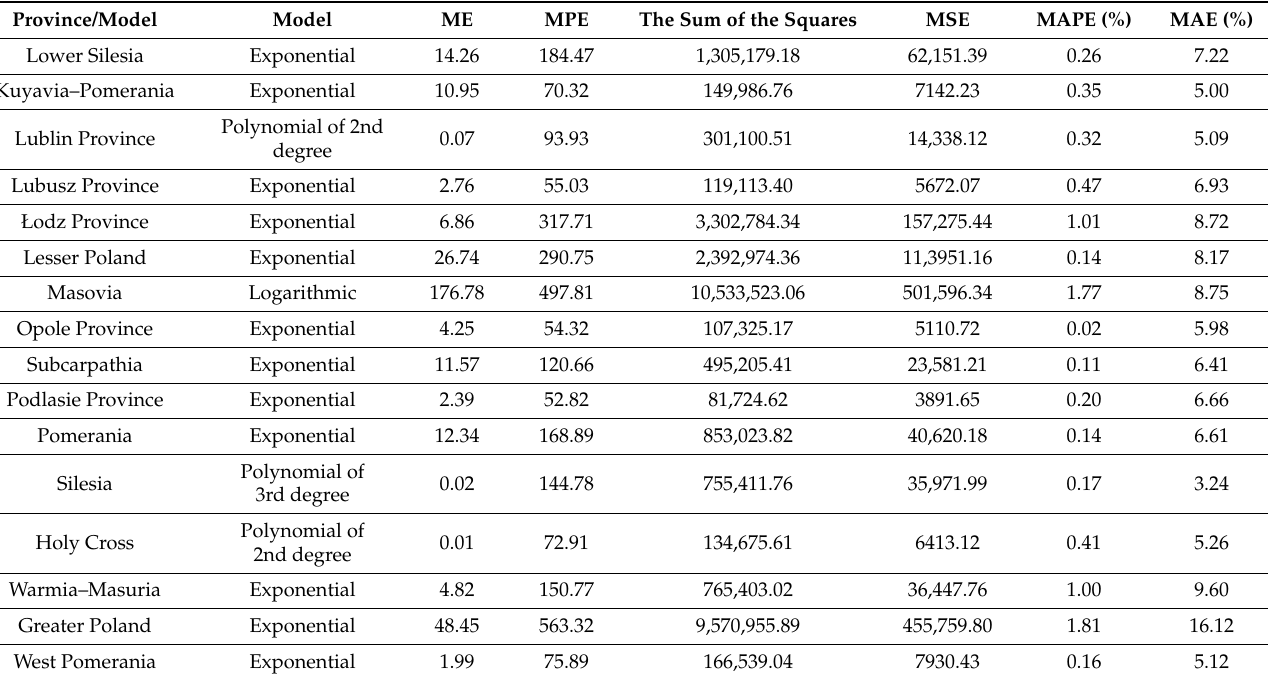
Table 4. Summary of errors for annual data.